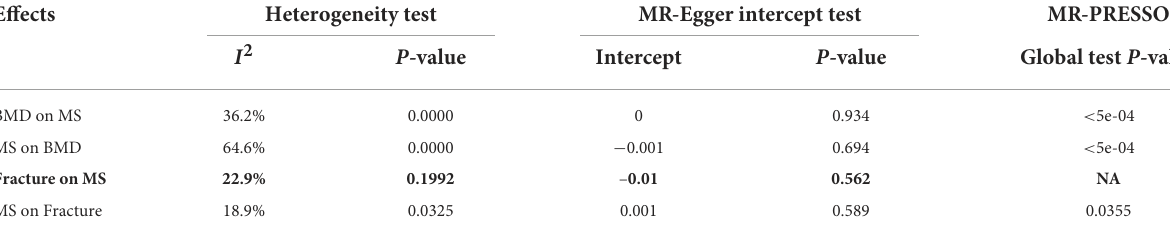
TABLE 4 Pleiotropy analysis about the causal association of BMD and fracture with